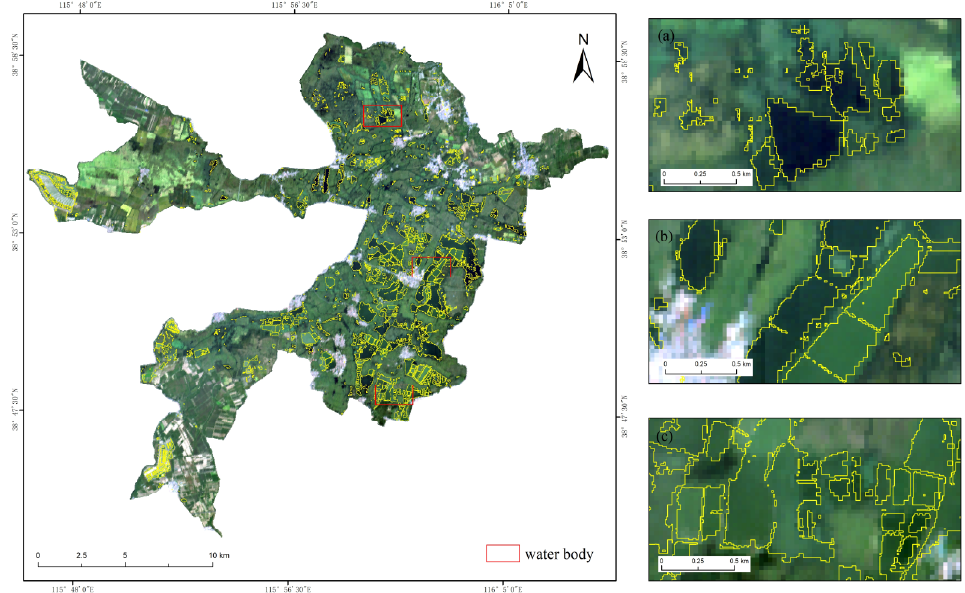
Figure 5. Boundaries of Baiyangdian surface water bodies. ( a ) Shaochedian Lake; ( b ) Laowangdian Lake; ( c ) Mengjiadian Lake.